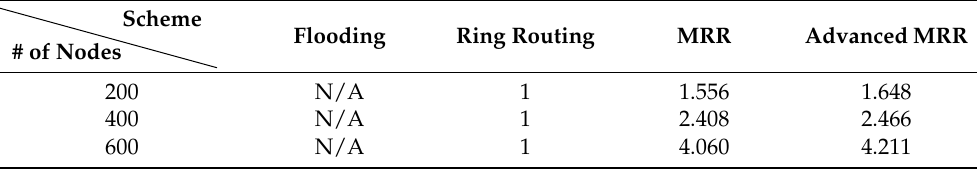
Table 4. Average number of rings per network